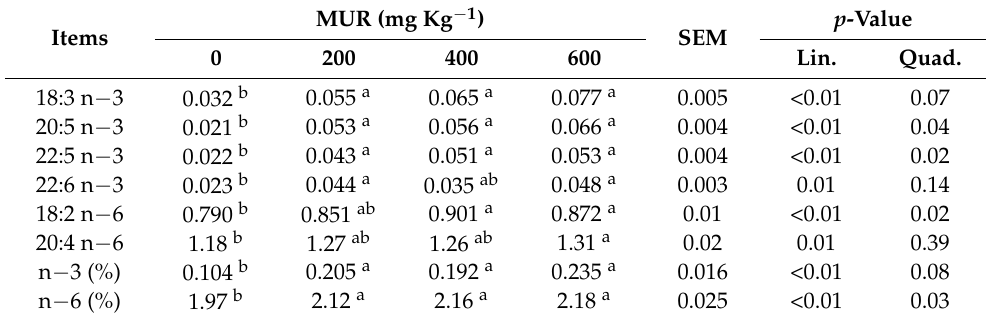
18:3 n − 3: α -linolenic acid, 20:5 n − 3: eicosapentaenoic acid, 22:5 n − 3: docosapentaenoic acid, 22:6 n − 3: docosa- hexaenoic acid, 18:2 n − 6: Linoleic acid, 20:4 n − 6: arachidonic acid, n − 3: omega 3 PUFA, n − 6: omega 6 PUFA.